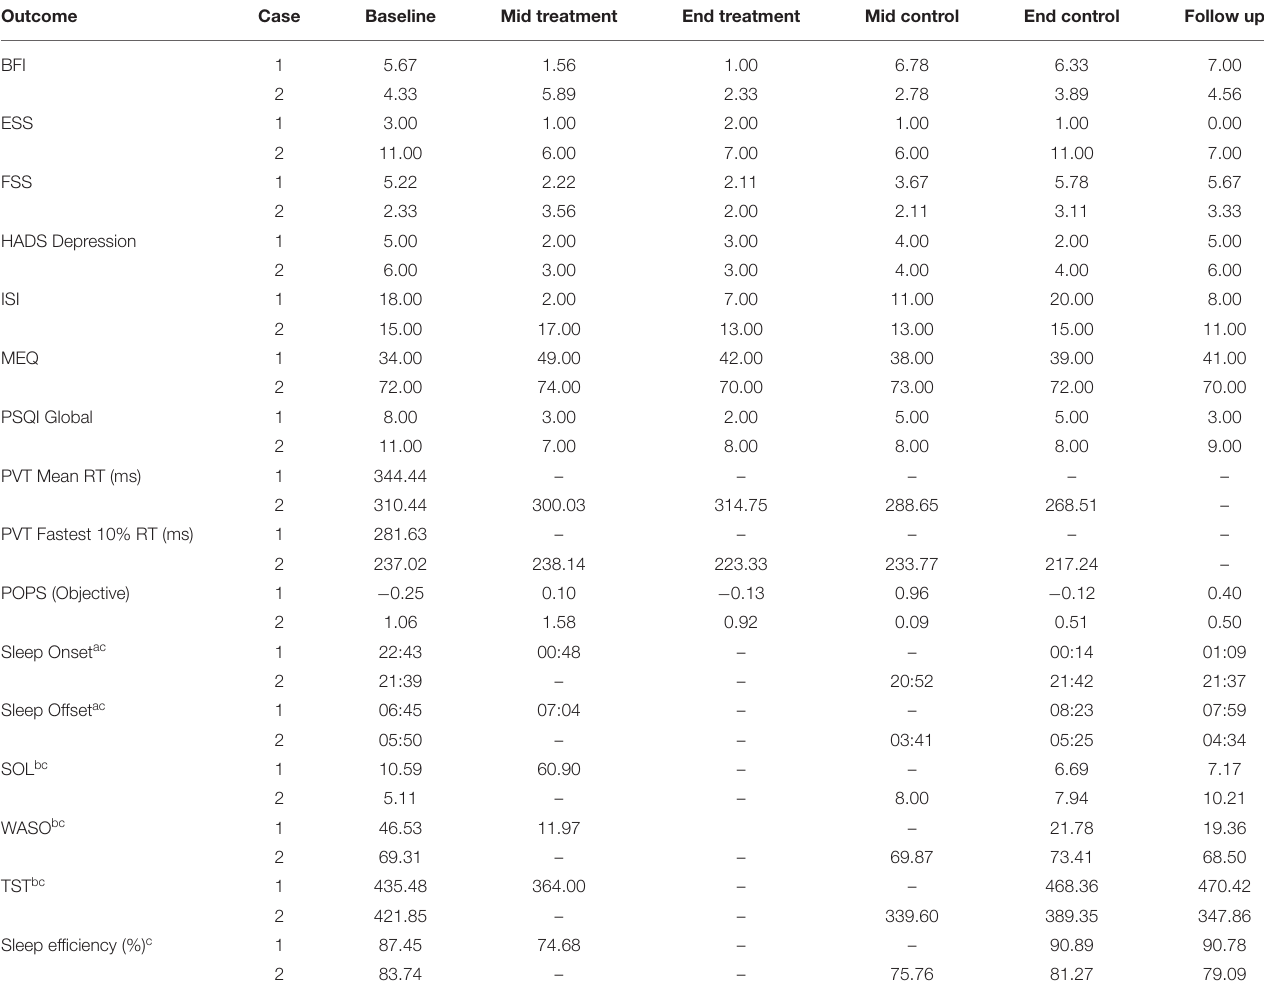
TABLE 2 | Case 1 and 2 outcomes at baseline, mid- and end Treatment and mid- and end Control.